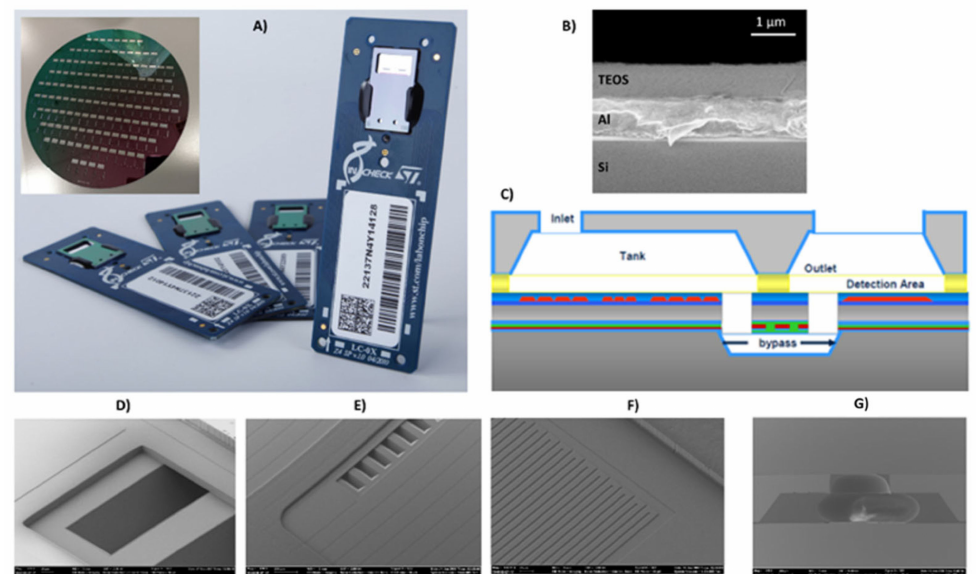
Figure 1. ( A ) Silicon LoC developed by STMicroelectronics (inset the silicon-cap wafer); ( B ) mul- tilayered detection area, fluidics inlet; ( C ) schematic of the LoCs; ( D ) bypass inlet; ( E ) bypass outlet; ( F ) metal sensor; ( G ) inlet silicon